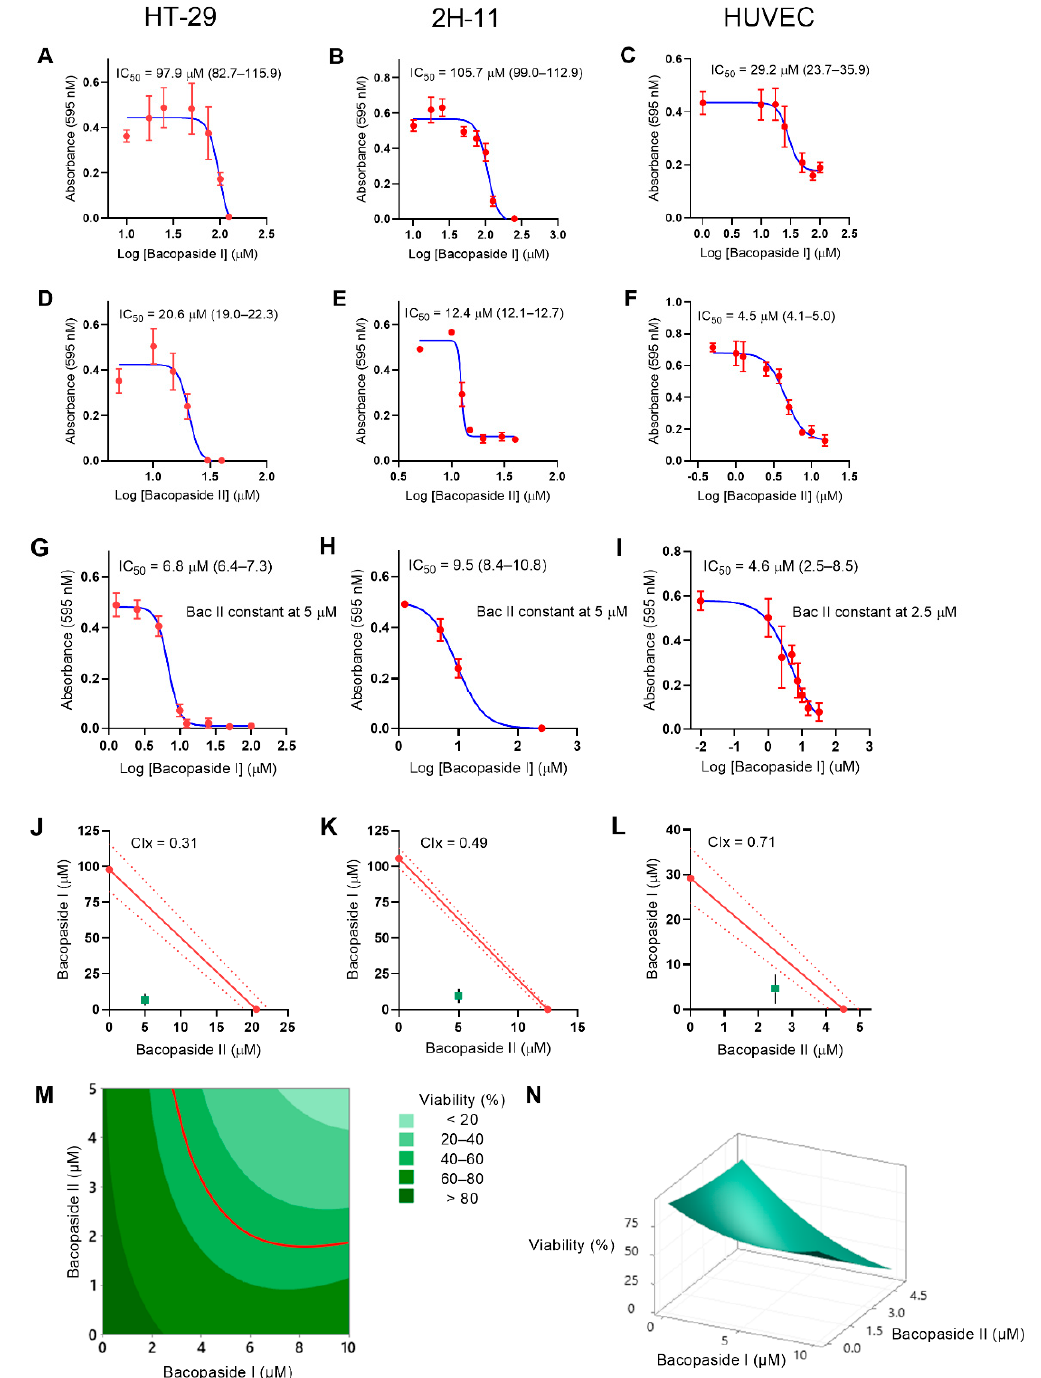
Figure 1. Comparison of the half maximal inhibitory concentration (IC 50 ) values of bac I and II, alone and combined, and their combination index (CIx) in HT-29, 2H-11 and HUVEC. Cell growth was measured by a crystal violet assay and IC 50 was determined by nonlinear regression analysis of 6 replicates. Dose–response curves show IC 50 for bac I ( A – C ), bac II ( D – F ) and combinations ( G – I ). Error bars represent the 95% confidence interval (CI). On the isobolograms ( J – L ), theoretical IC 50 lines (red solid lines) acquired from the IC 50 for each compound used individually, and the measured IC 50 (green square) for bac I and II combined, are plotted for each cell line, with 95% CI being represented by the red dotted lines for theoretical IC 50 lines and by the black lines for measured IC 50 . Response surface methodology (RSM) analysis was performed on HUVEC viability, and the contour plot ( M ) and surface plot ( N ) are drawn, with the red line indicating the 50% probability